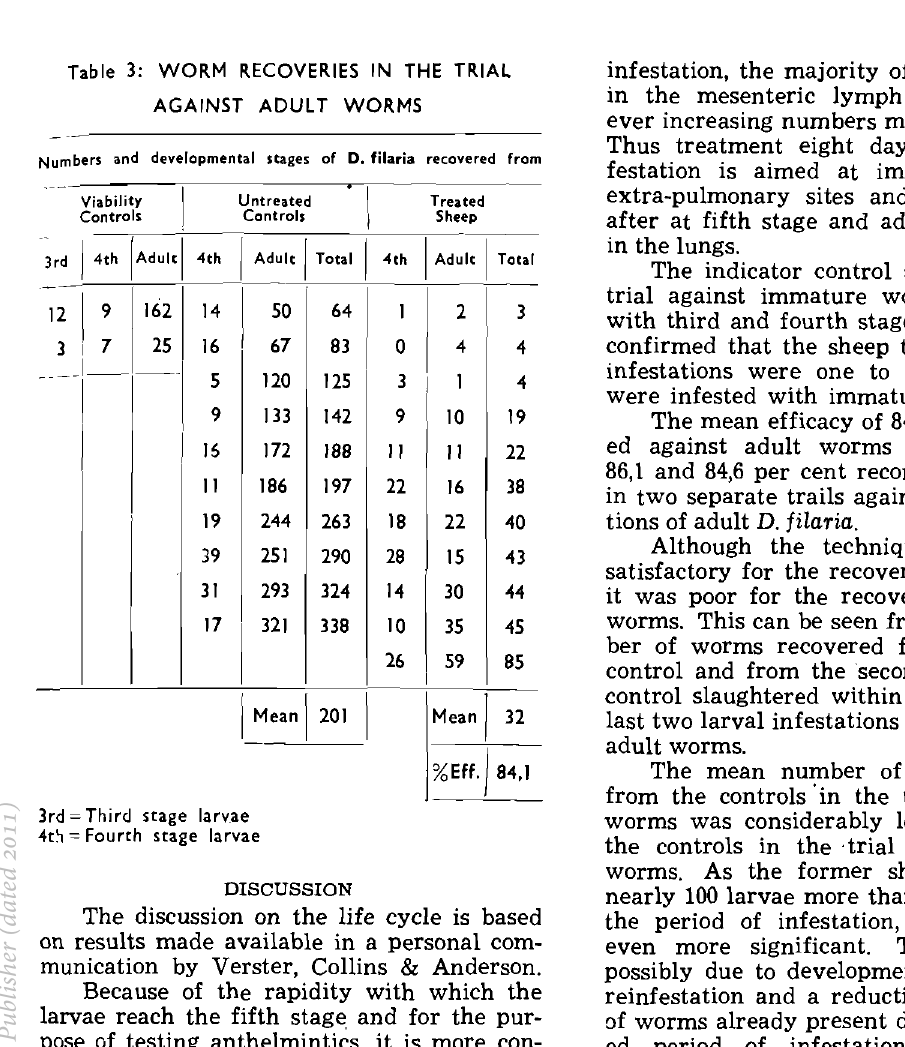
Table 3: WORM RECOVERIES IN THE TRIAL AGAINST ADULT WORMS Numbers and developmental stages of D. filaria recovered